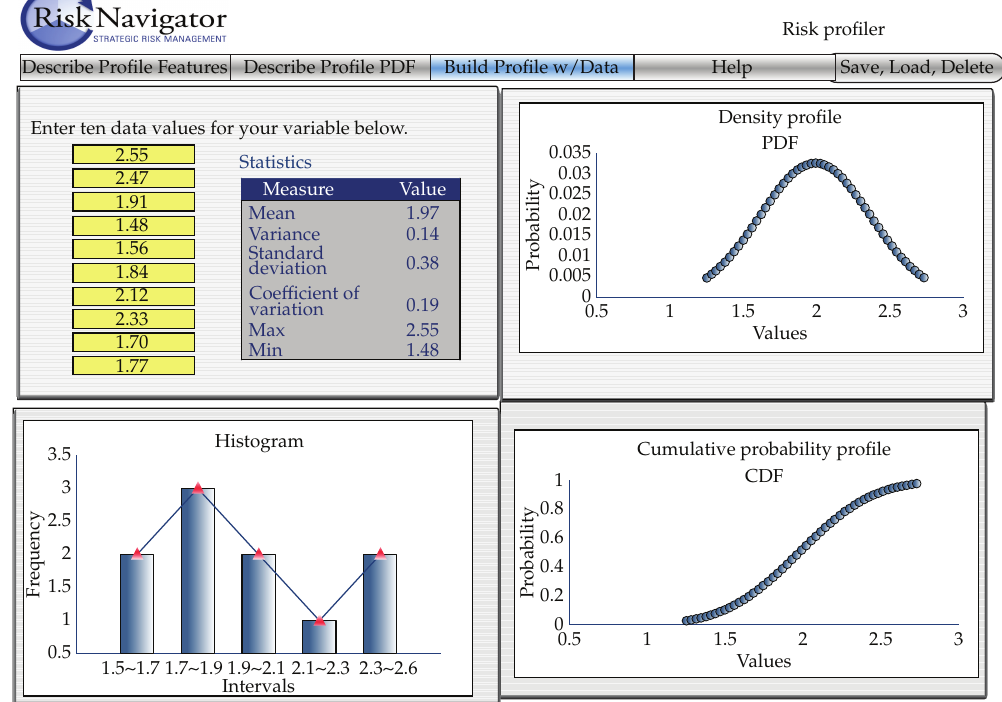
Figure 4: Building a PDF with Risk Profiler; see source in (cid:4) 6 (cid:5)